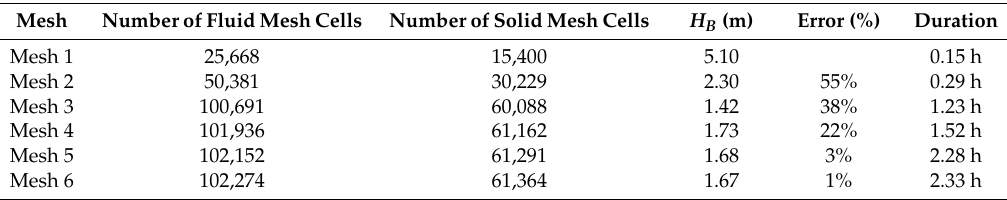
Table 3. Summary of Mesh Sensitivity Analysis (MSA).